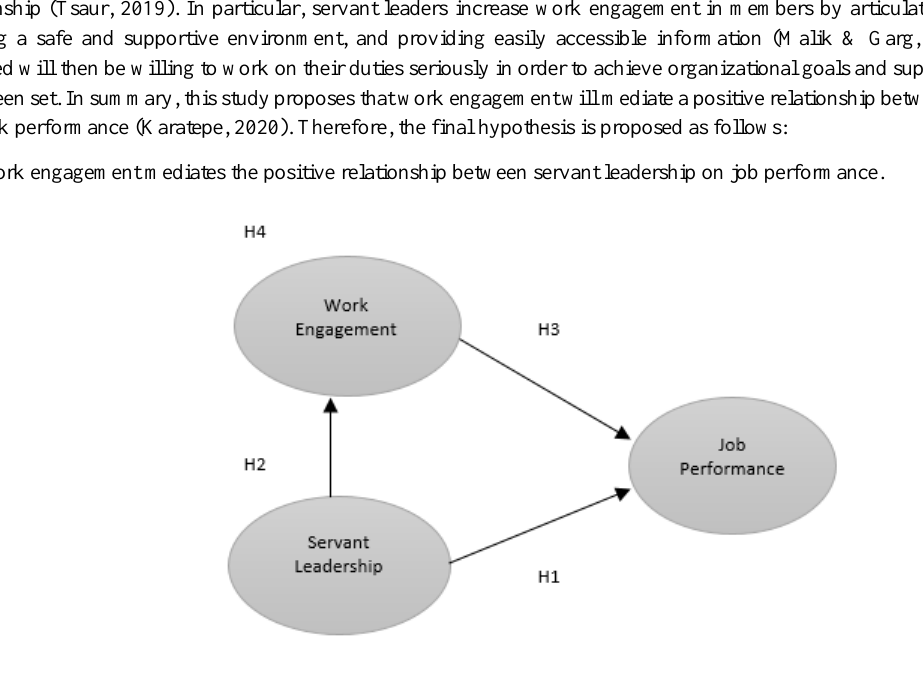
Figure 1 : Conceptual Framework; Source: